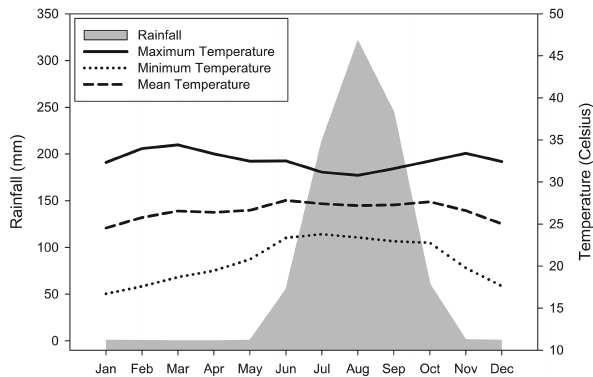
Figure 1. Average rainfall (mm) and maximum, mean and mini- mum temperatures (degrees Celsius) per month of the year (from 1970 until